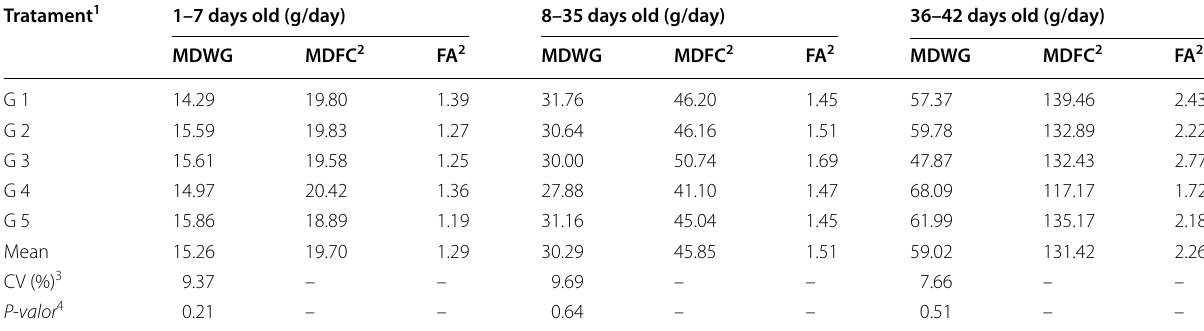
Table 2 Mean daily weight gain of birds (MDWG), mean daily feed consumption (MDFC) and feed conversion (FA) of bords of the line